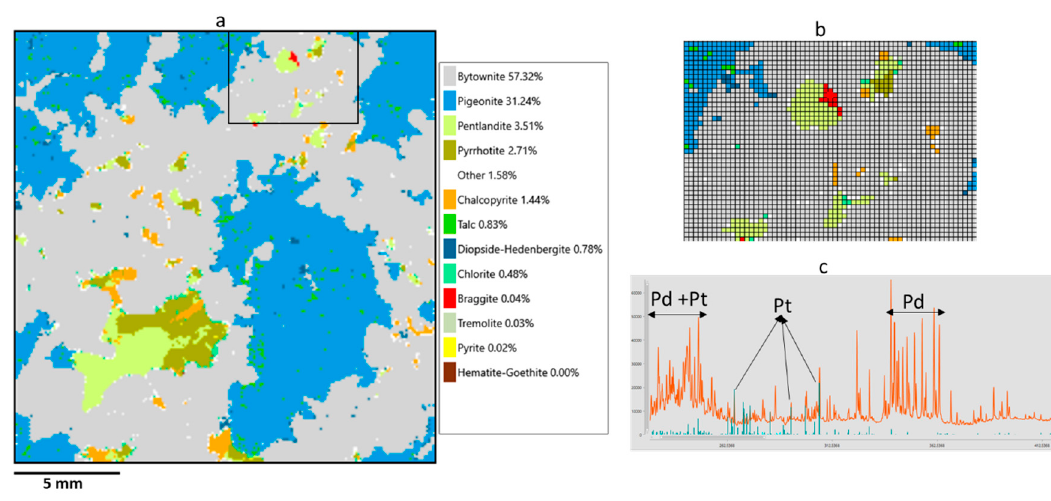
Figure 8. LIBS mineral map of the sample PGE2 used in [23] showing ( a ) the Pt-Pd mineral braggite (enlarged in ( b )) and ( c ) the braggite spectrum taken in the red area of Figure 8b.